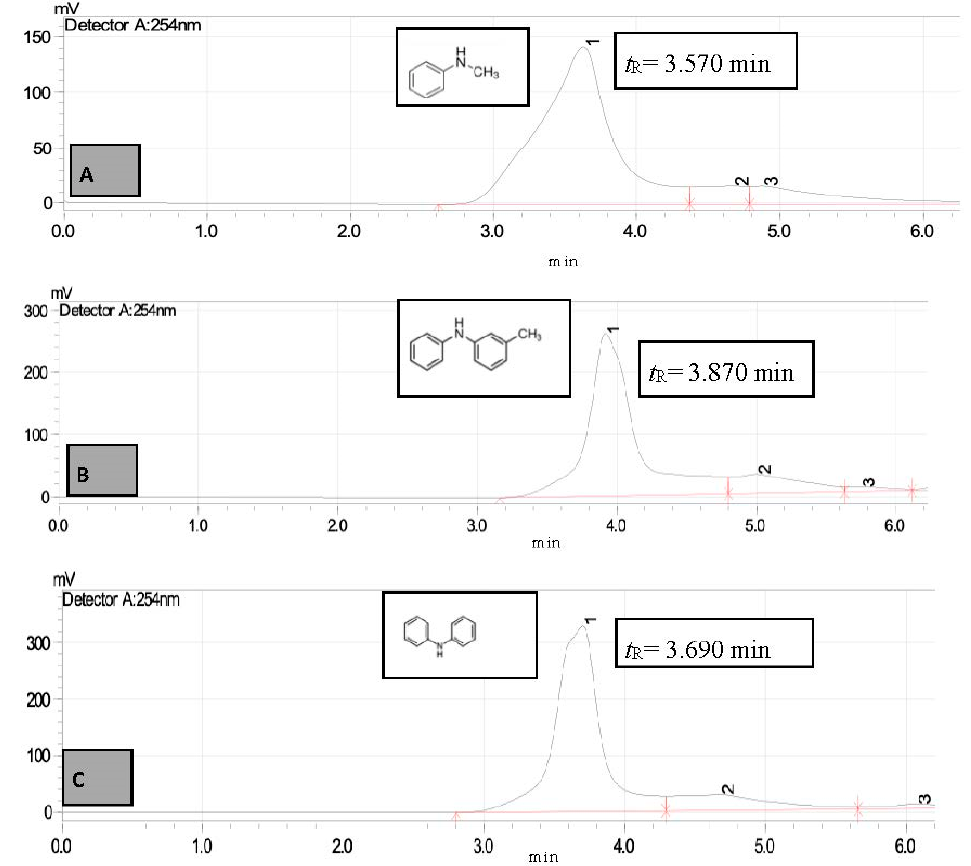
Figure 7. HPLC chromatogram of standard secondary amines ( A )—N-methylaniline ( t R = 3.570 min) ( B )—3-Methyldiphenylamine ( t R = 3.870 min) and ( C )—Diphenylamine ( t R = 3.690 min).